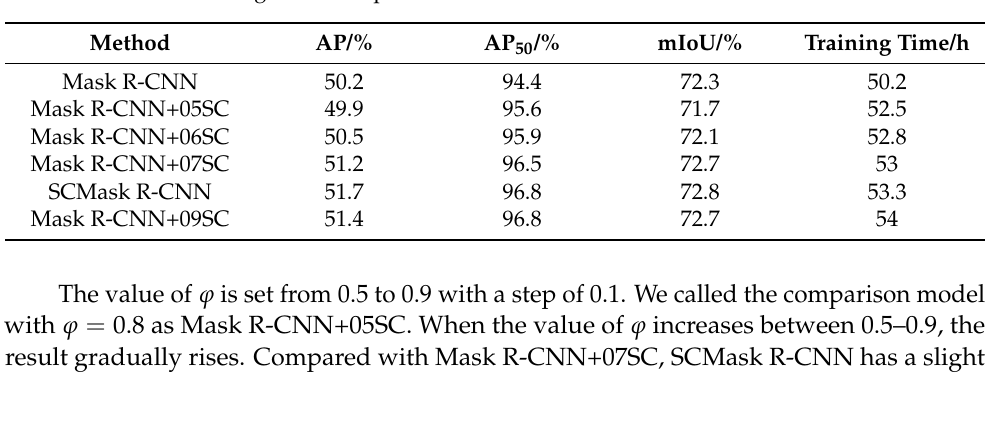
Table 2. Detection and segmentation performance of different